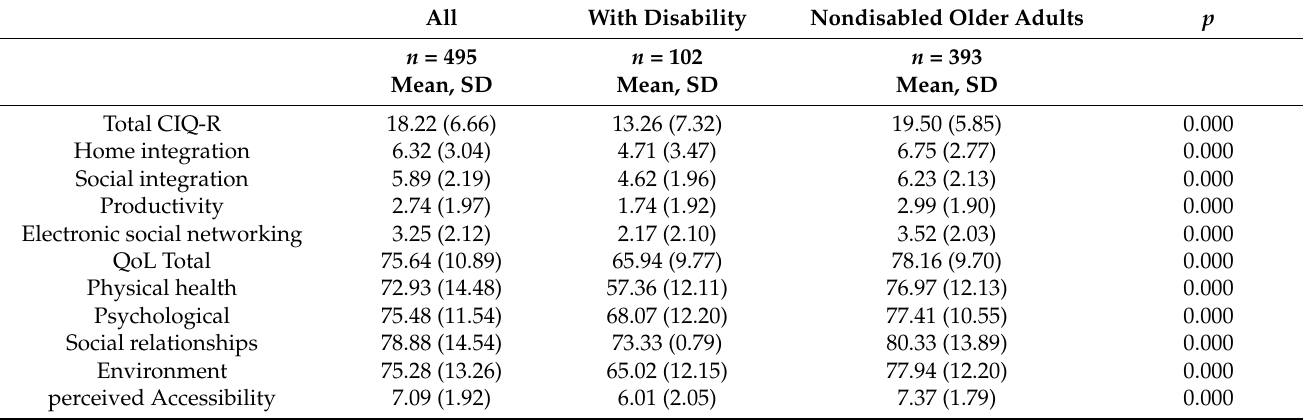
Table 2. Differences between older adults with functional disabilities and healthy older adults in research